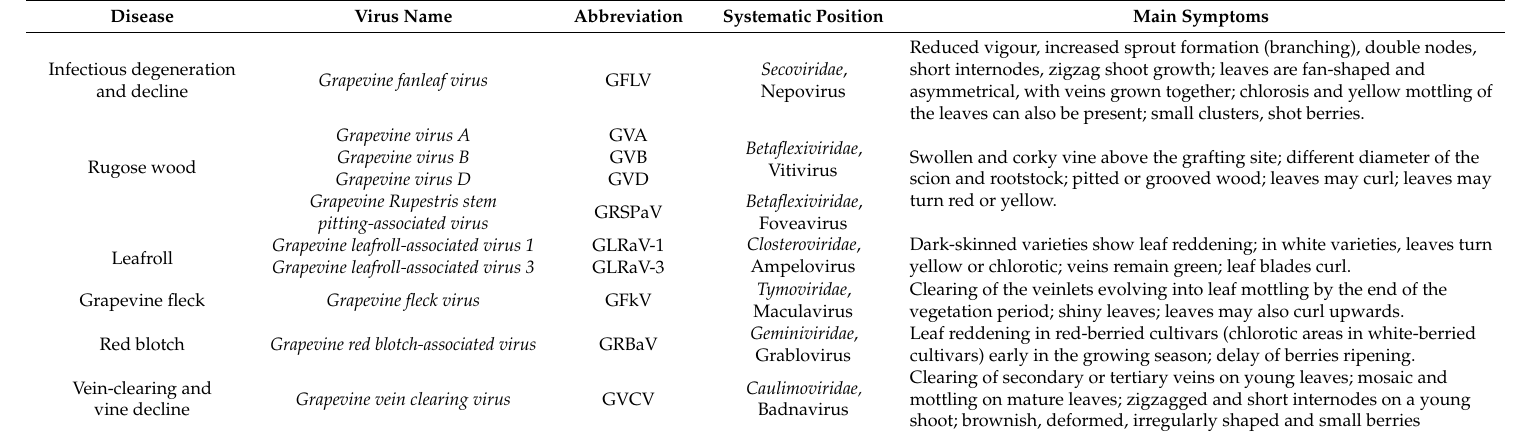
Table 1. The main viruses causing diseases in grapes and infection